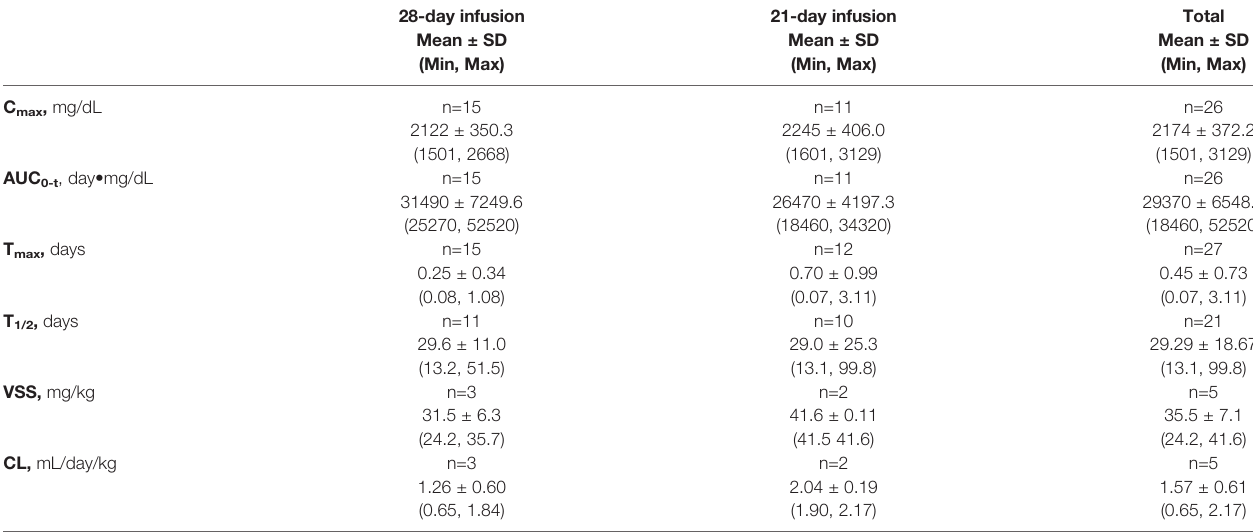
TABLE 9 | Pharmacokinetics of total IgG* PK